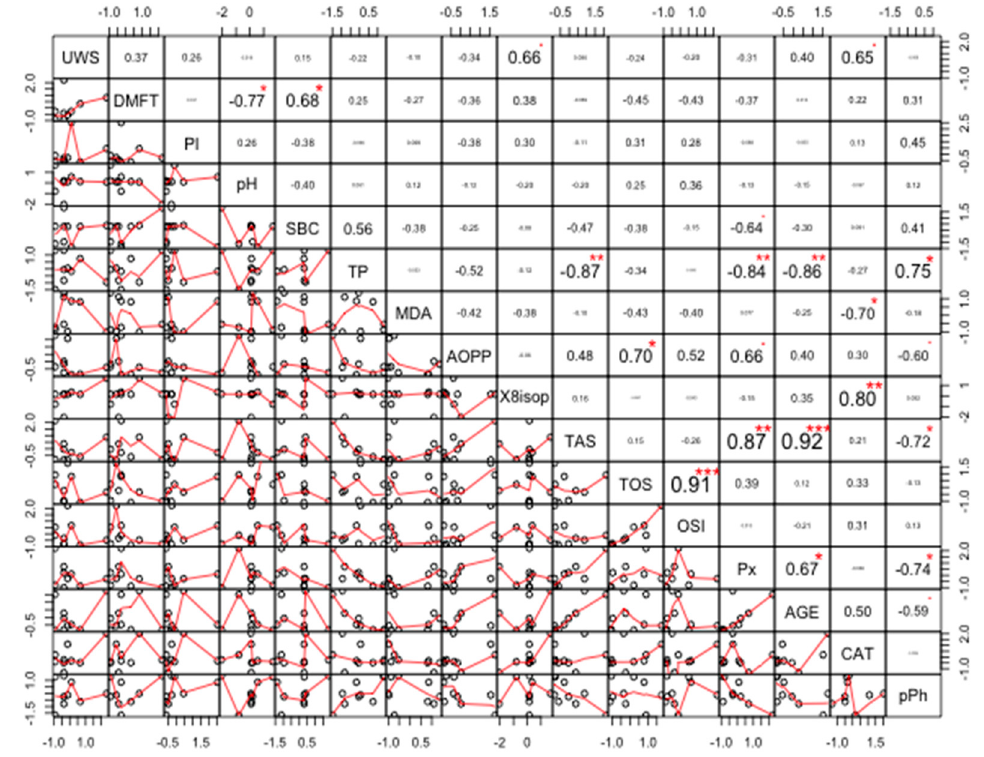
Figure 13. Coefficients of correlation between parameters analyzed in the saliva of women with breast cancer and without the BRCA1 mutation (NC). NC, patients with breast cancer but without the BRCA1 mutation; AOPP, advanced oxidation protein products; TP, total protein; OSI, oxidative stress index; TOS, total oxidant status; TAS, total antioxidant status; CAT, catalase activity; pPh, total phenolic content; Pl.I score, Plaque Index; DMFT, decay, missing, filled teeth; UWS, unstimulated whole saliva; SBC, salivary buffer capacity; 8-isop, concentration of 8-isoprostane; MDA, concentration of malondialdehyde; AGE, advanced glycation end-products; SBC, buffer capacity of saliva; Px, activity of salivary peroxidase. * p < 0.05; ** p < 0.01; *** p < 0.001.